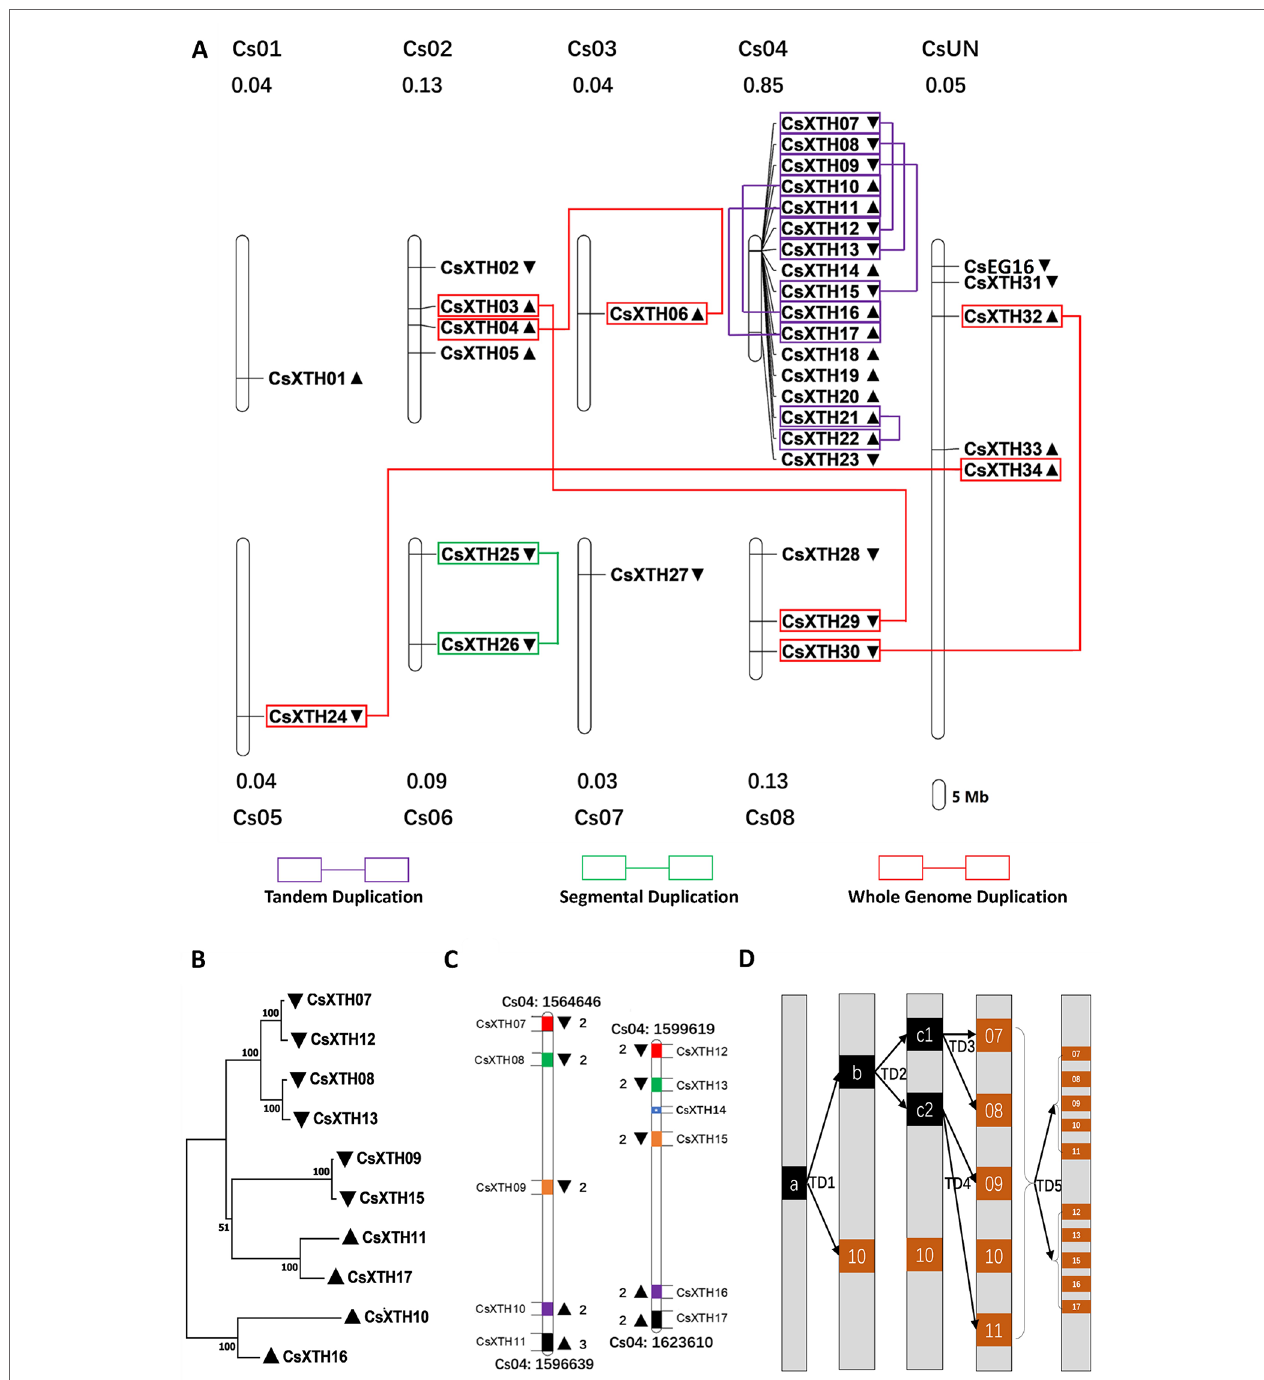
FIGURE 2 | Chromosomal loci and duplications hot spots of CsXTH genes. (A) Chromosomal locations and duplications of CsXTH and CsEG16 genes. The map was visualized by MapChart 2.1, and the concentration of CsXTH genes (number of CsXTHs per Mb) are written above each chart. Gene orientations are shown in nearby triangles. (B) Maximum-likelihood phylogeny of duplicated CsXTH genes on chromosome 4 (MEGA 7, bootstrap = 500). (C) Comparison of two duplicated segments. Gene sizes and intervals are to scale. Start and stop positions of the duplicated segments were written on the top and bottom of the segments. Gene orientations are shown with triangles on the left and right. Homologous genes are shown in the same color on the two duplicated segments. (D) Model for the evolutionary history of the two duplicated segments. a, b, and c represent ancestral genes during the evolution process. 07–17 represent CsXTH07–CsXTH17,